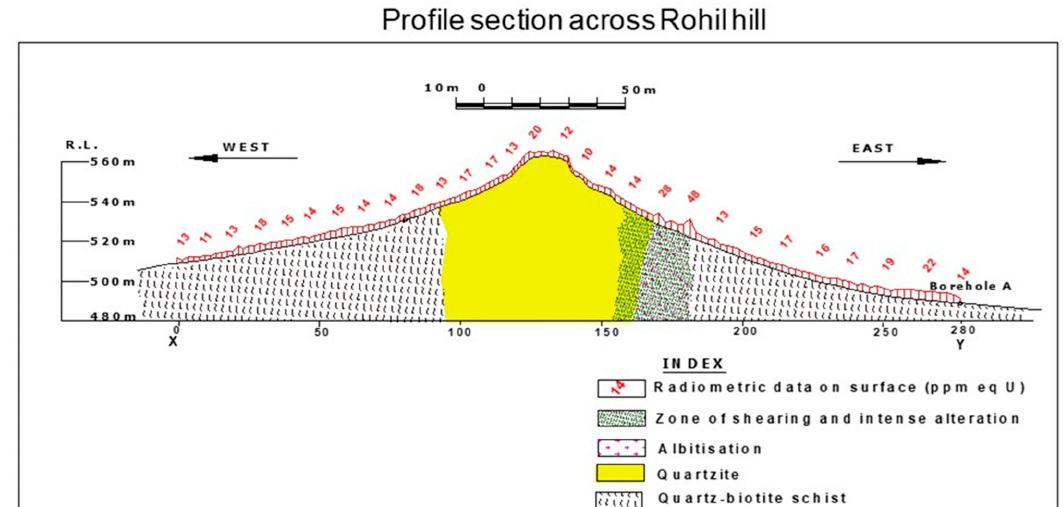
Figure 7. Profile section (EW) across the hill showing the disposition of litho-units and radiometric data. The plotting of data of an elemental concentration was carried out along a transverse section line across the trend of one lode zone (Figure 8).